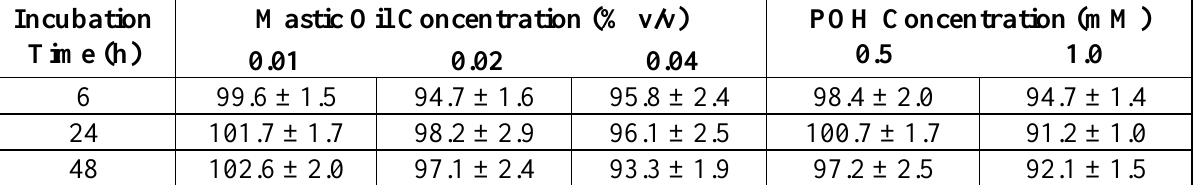
Table 1. Viability of Lewis lung adenocarcinoma (LLC) cells after